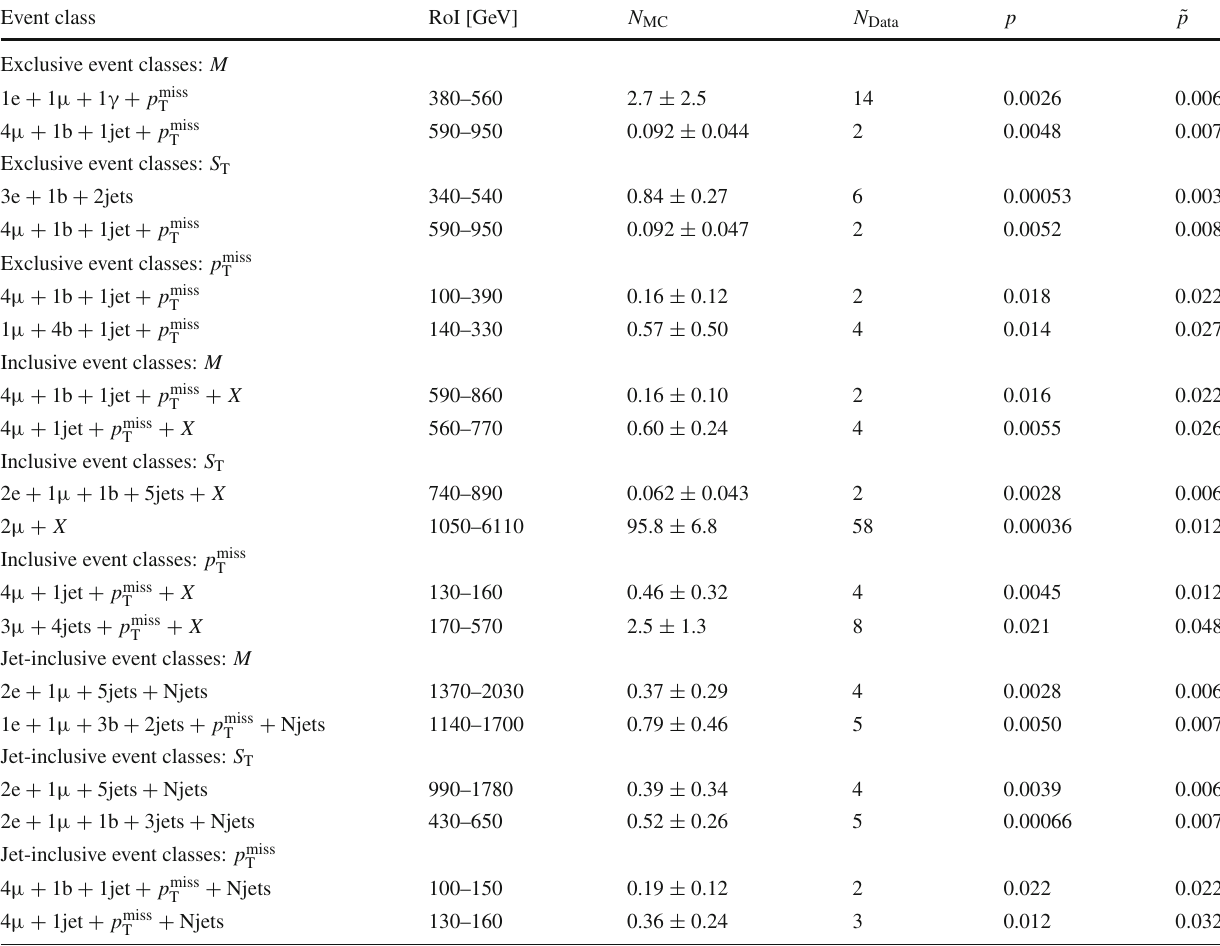
Table 5 Overview of the two most significant event classes in each RoI scan. Details of the RoI, the expectation from the SM simulation, and the number of data events within the RoI are shown along with the p and ˜ p values Event class RoI [GeV] N MC N Data p ˜